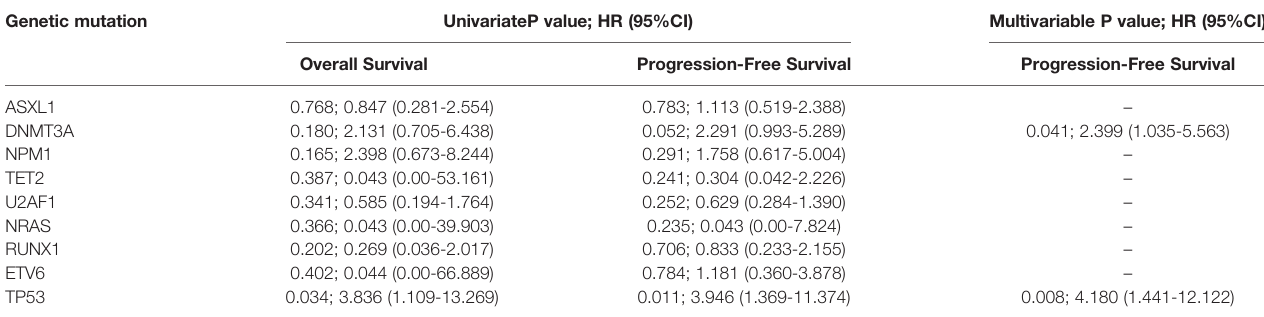
TABLE 2 | Genetic mutations at diagnosis for survival outcomes. Genetic mutation UnivariateP value; HR (95%CI) Multivariable P value; HR